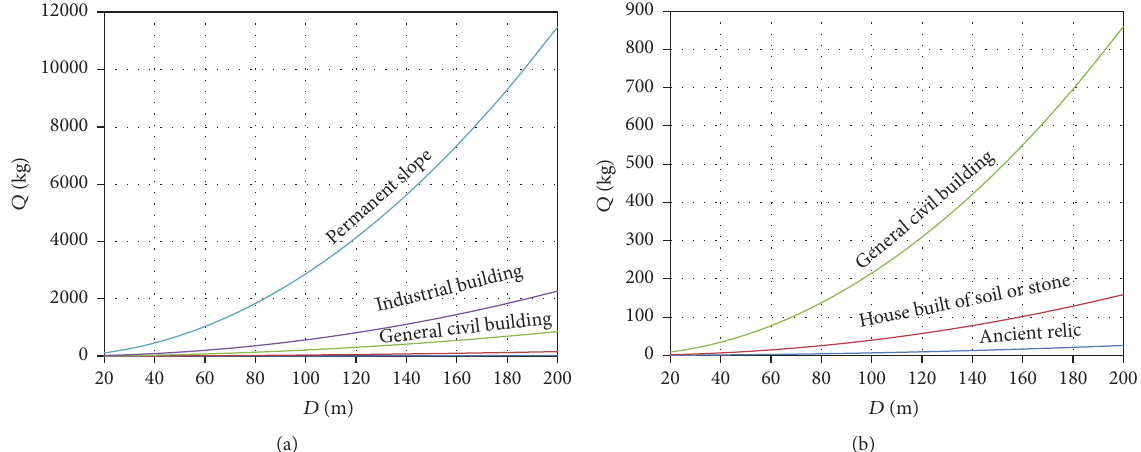
Figure 11: Control of maximum charge per delay for different protection objects dependent on 𝐷 . (a) Total figure. (b) Partial figure.